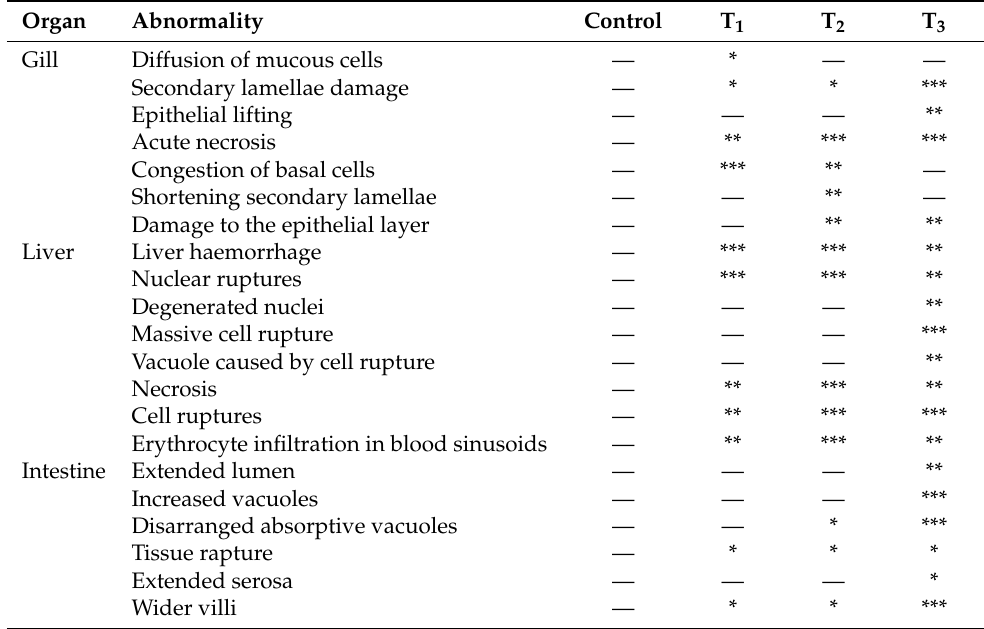
Table 6. Comparative investigation of histopathological alterations from the current experiment in different treatment